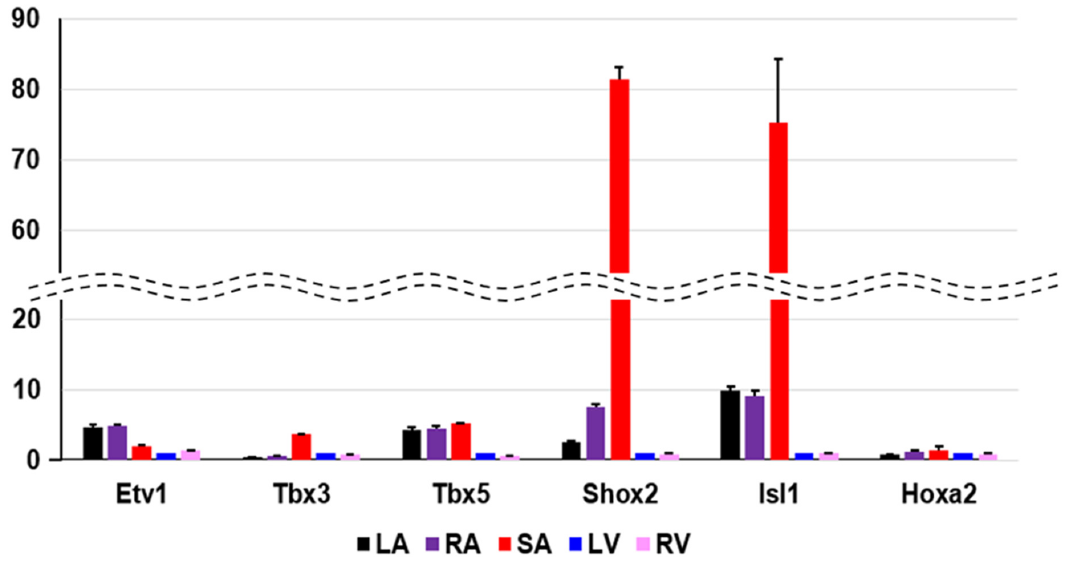
Figure 5. Quantitative PCR validation of selected transcripts. The PCR result measures the expression of the ventricle with arbitrary unit 1, and shows how many times more than the expression of the